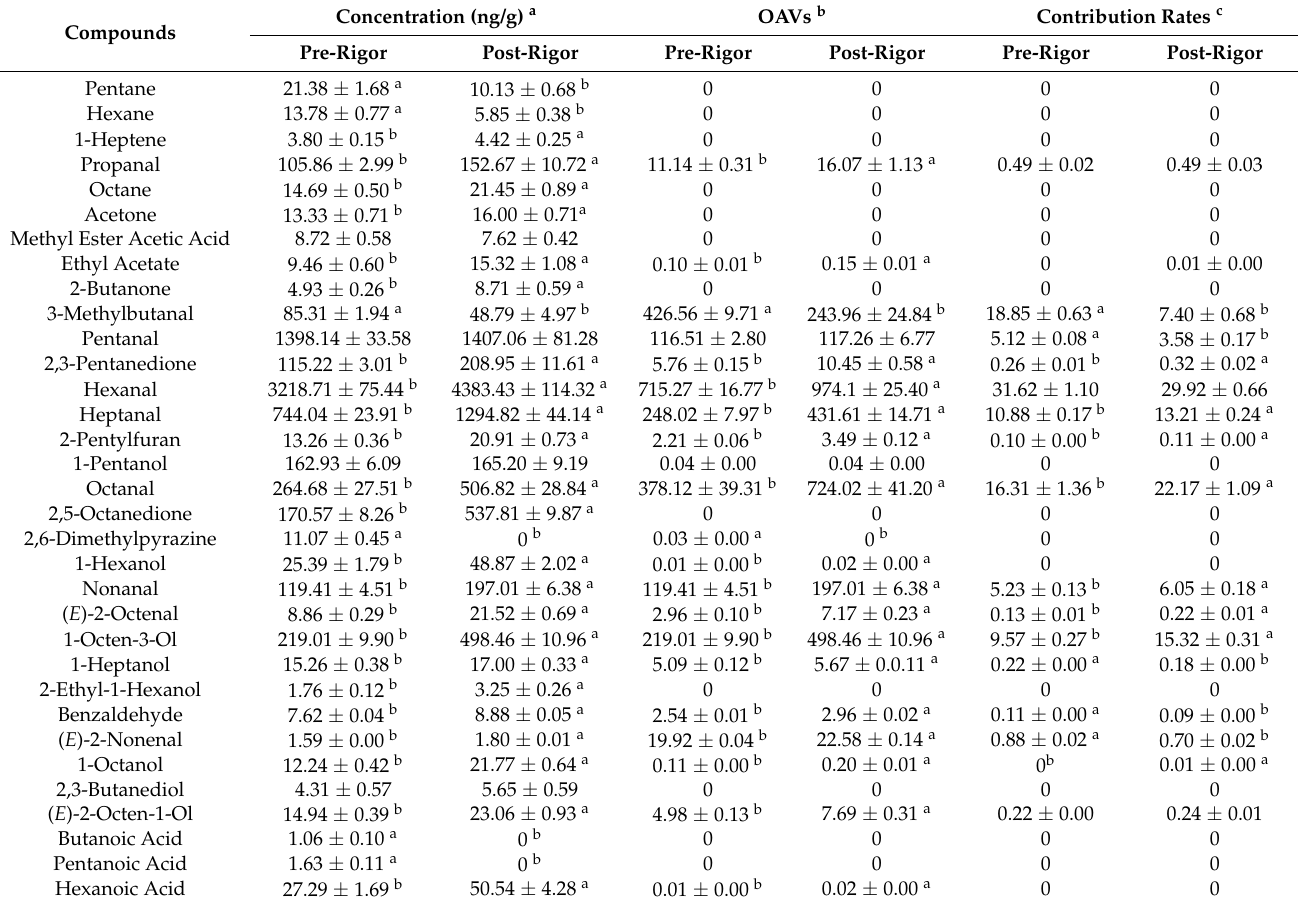
Table 3. Concentrations, OAVs, and contribution rates of aroma compounds in the pre- and postrigor roasted mutton. Compounds